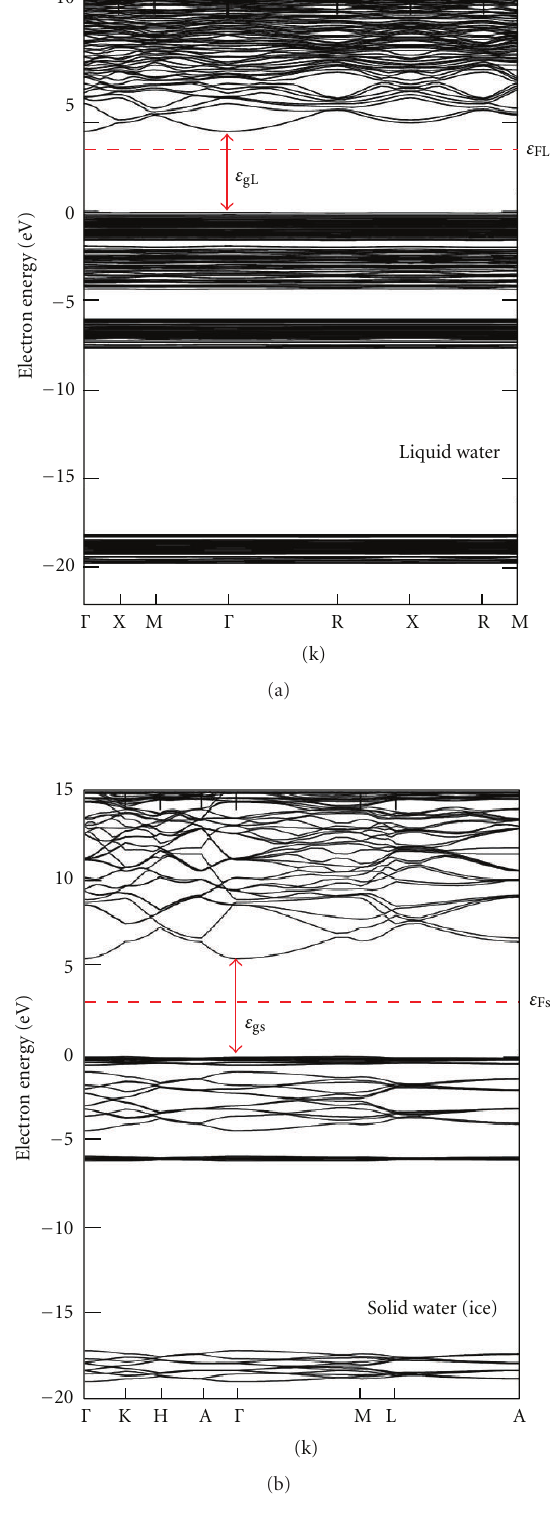
Figure 4: Brillouin bands of liquid (a) and solid (b) water [26]; here the zero energy of electrons corresponds to the top of valence band and red dotted lines are Fermi levels, ε Fl and ε Fs , of electrons in liquid and solid water with corresponding band gaps, ε gl and ε gs